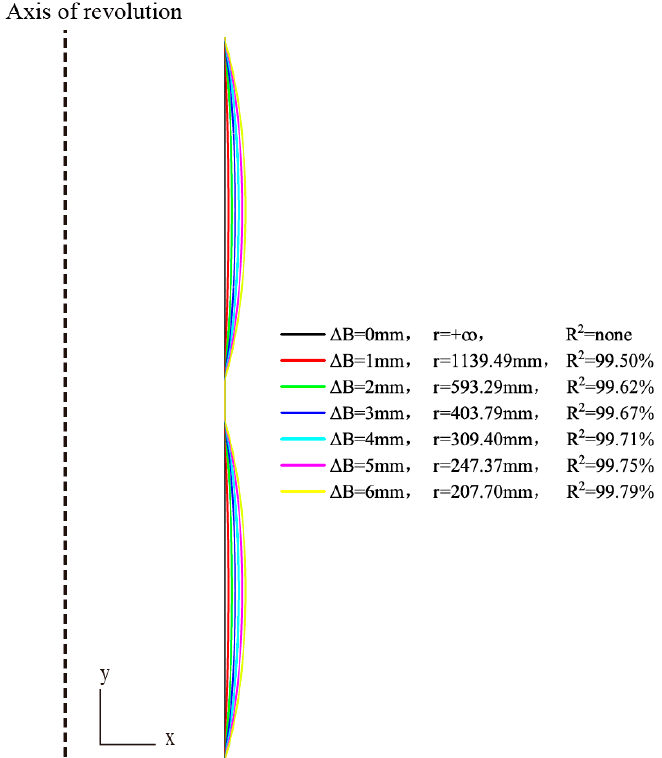
Figure 17. Deformed meridians of bi-segment pressure hulls with various bulging magnitudes obtained from numerical analysis, where r is the fi tt ed radius of each curve and 𝑅 (cid:2870) is the coe ffi cient obtained from numerical analysis, where r is the fitted radius of each curve and R 2 is the coefficient of determination. of determination.